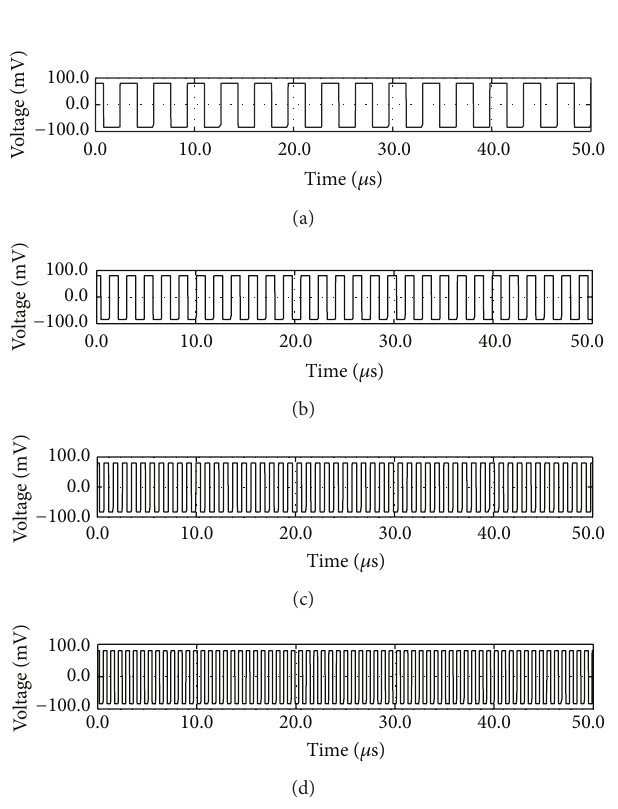
Figure 16: Output voltage with 𝐼 (b) 20 𝜇 A, (c) 40 𝜇 A, and (d) 50 𝜇 A.